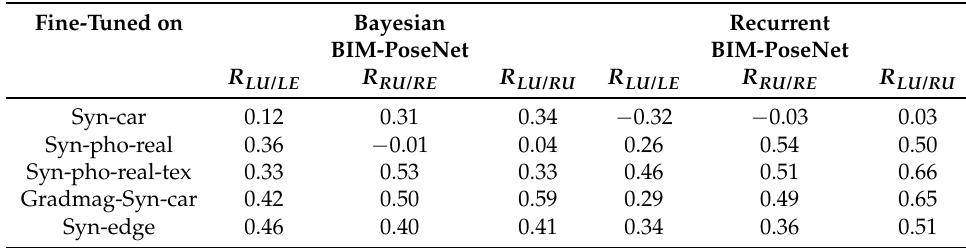
Table 4. The comparison of error and uncertainties for Recurrent BIM-PoseNet with Bayesian BIM-PoseNet. Fine-Tuned on Bayesian Recurrent BIM-PoseNet BIM-PoseNet R LU / LE R RU / RE R LU / RU Syn-car 0.12